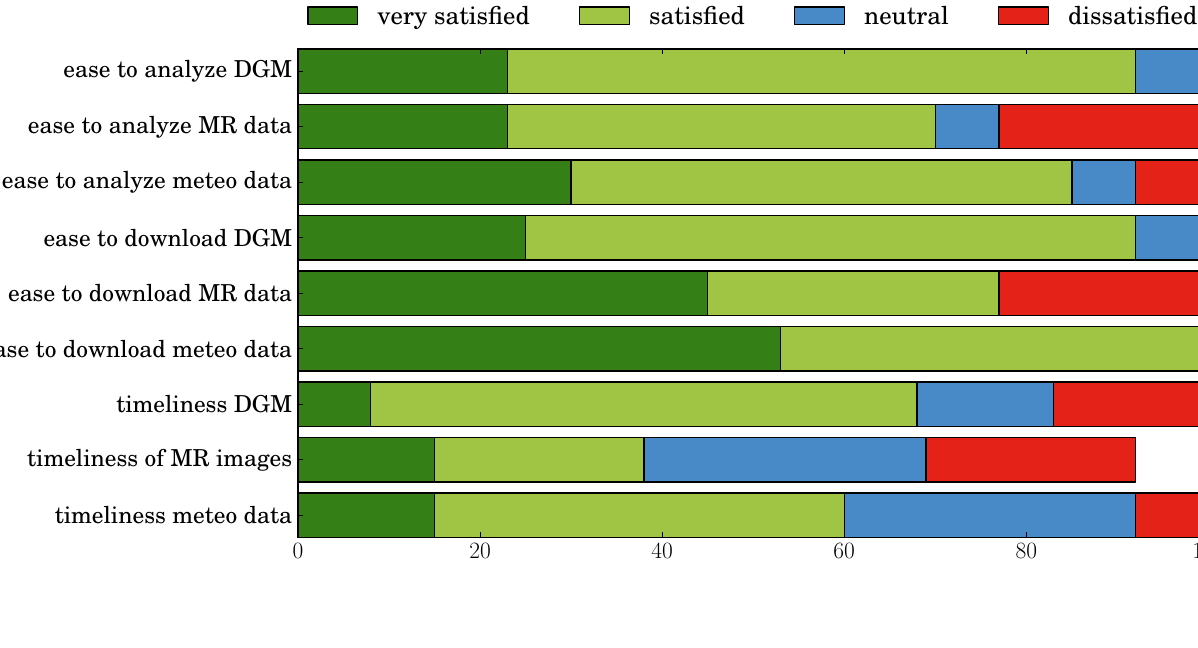
Figure 8. Results of the user survey. National information officers are generally